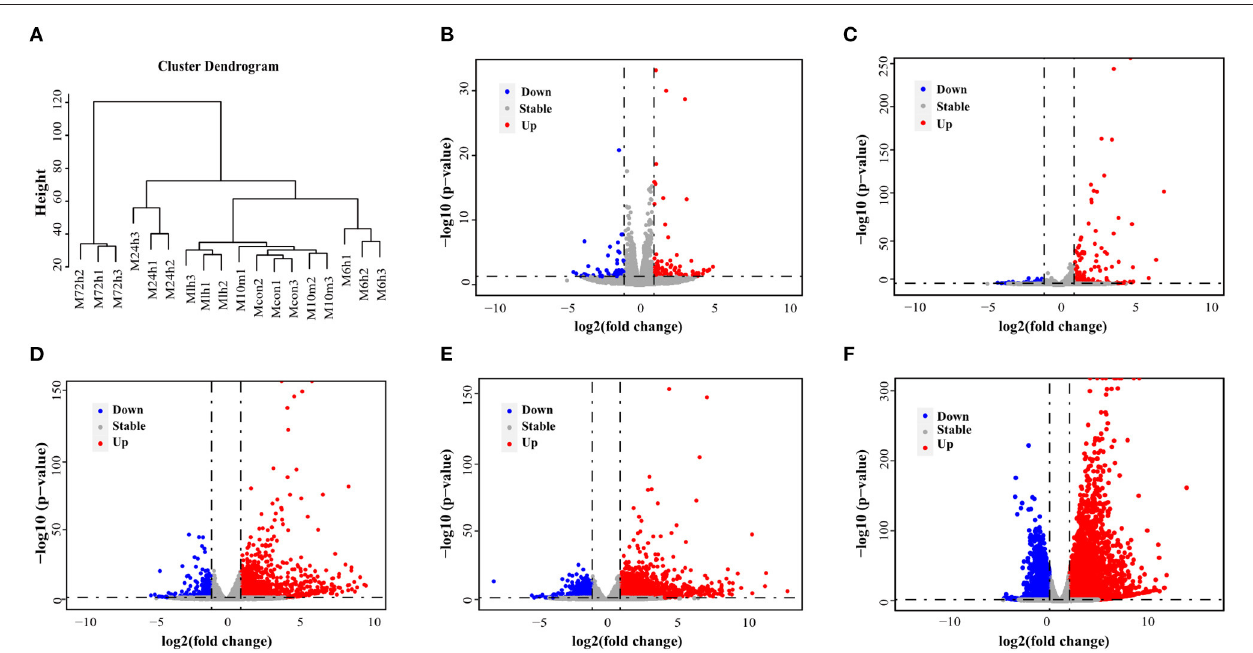
FIGURE 2 | DEGs in mouse model of MI derived by RNA-Seq. (A) An unsupervised cluster analysis of MI at 6 different time points. (B–F) Volcano plot showing DEGs in 10min, 1, 6, 24, and 72h post-MI. Red dots indicate significantly upregulated mRNAs, and blue dots indicate downregulated